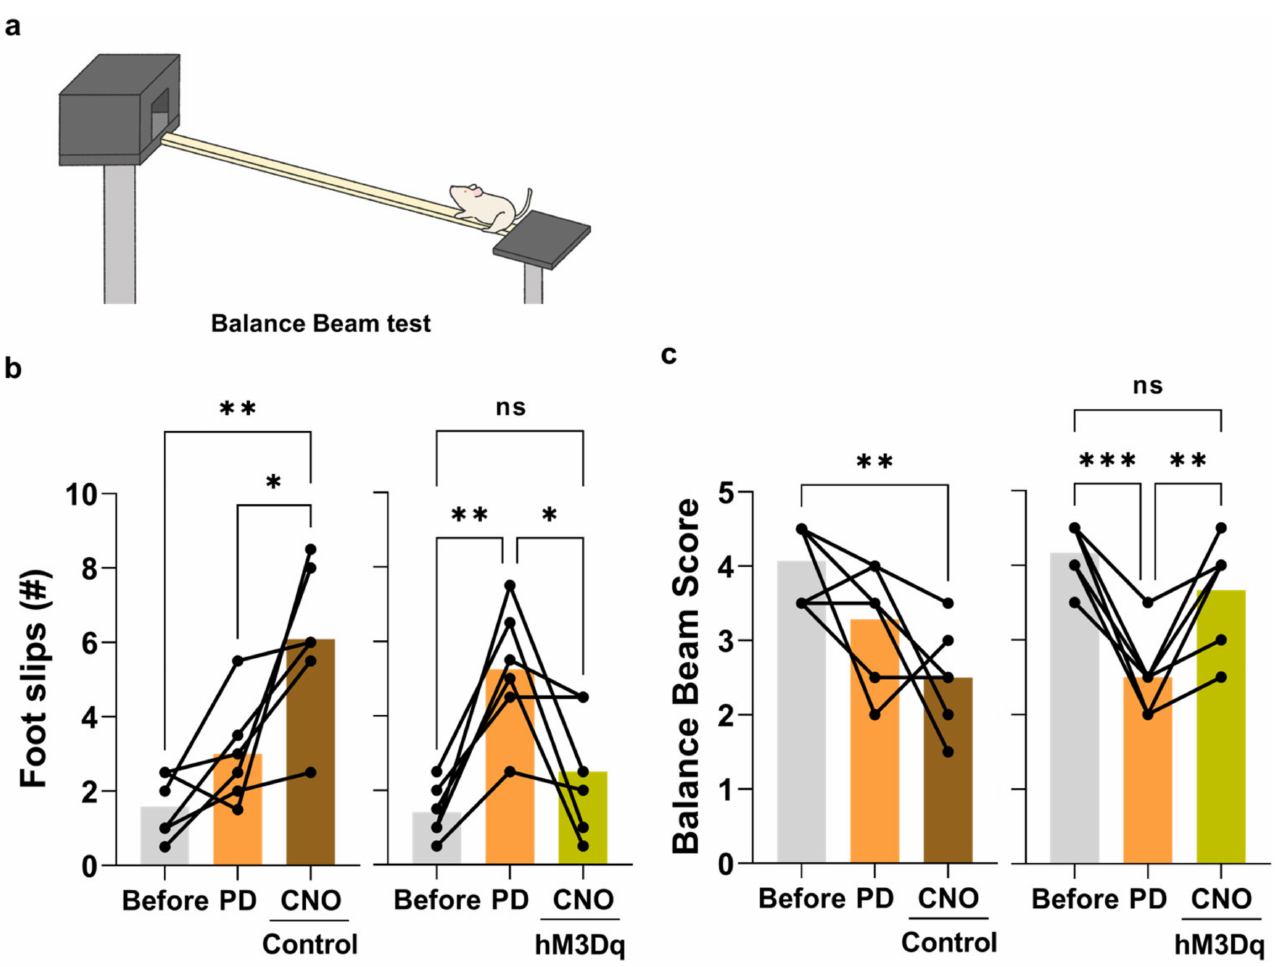
Figure 4. Chemogenetic activation of DDC neurons recovers PD-like motor symptoms of the A53T rat PD model in the balance beam test. ( a ) Schematic figure of balance beam test; ( b ) quantification of slippery step number at each time point (Control, n = 6; hM3Dq + CNO, n = 6); ( c ) assessment of balance beam score, which is classified by the following criterion: 1, the rat tried to traverse the beam, but fell; 2, the rat traversed the beam with many slips (more than five times); 3, the rat traversed the beam with several foot slips (three to five); 4, the rat traversed the beam with few foot slips (one to two); 5, the rat traversed the beam without any slips of the hindlimb. The data normality was assessed by Shapiro–Wilk normality test. When the data is normally distributed, the statistical significance was calculated by repeated-measure one-way analysis of variance (ANOVA) with Tukey’s multiple comparison test (b and c-right). When the data is not normally distributed and the statistical significance was calculated by Friedman analysis of variance (ANOVA) with Dunn’s multiple comparison test (c-left). The significance levels are represented as asterisks (* p < 0.05, ** p < 0.01, *** p < 0.001; ns, not